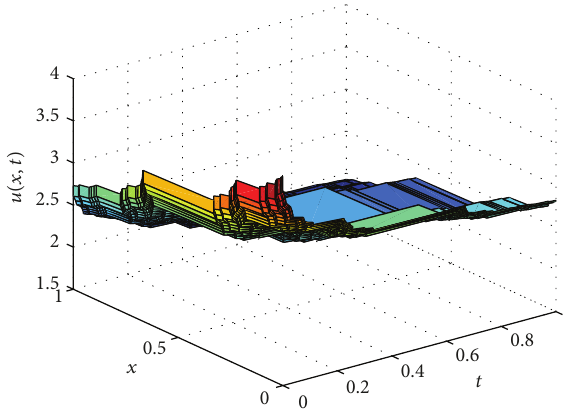
Figure 1: Plot of 𝑢(𝑥,𝑡) with the fractal dimension 𝛼 = ln 2/ ln 3